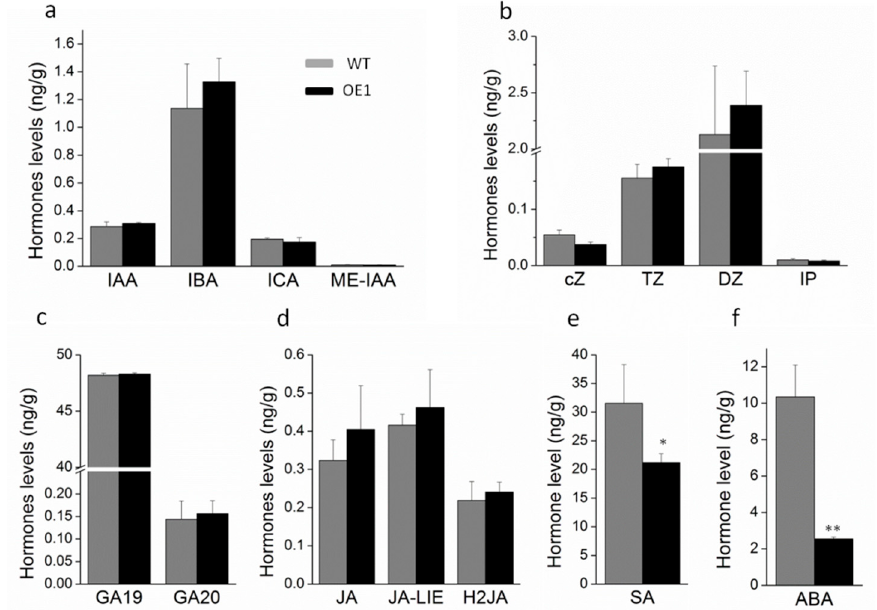
Figure 4. The concentrations of the hormones auxins ( a ), cytokinins ( b ), gibberellins ( c ), jasmonic acid ( d ), salicylic acid ( e ), and abscisic acid ( f ) in DRL-overexpressing transgenic and wild-type tobacco leaves. Bars represent mean ± SD. Significant difference from the WT was confirmed by Tukey’s test ( * p < 0.05 and ** p < 0.01).